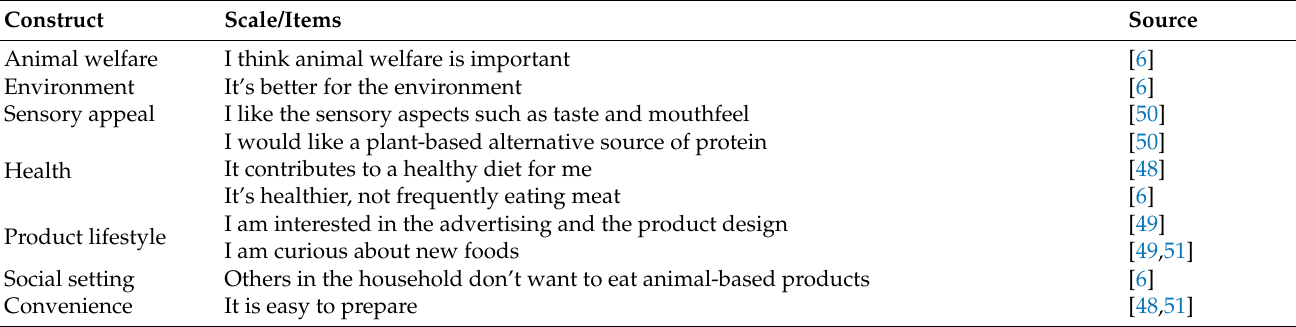
Table A1. Constructs of motivation with associated questionnaire items and sources.